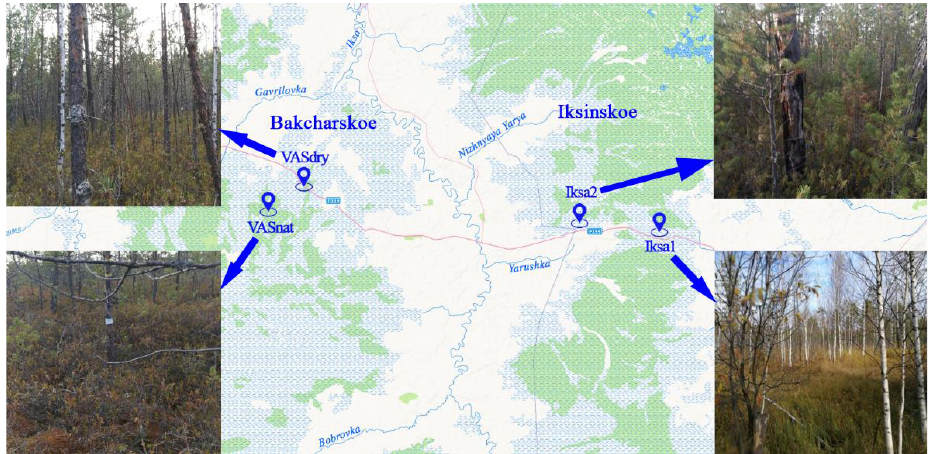
Figure 1. Site locations of studied peatlands, Western Siberia (Tomsk region).